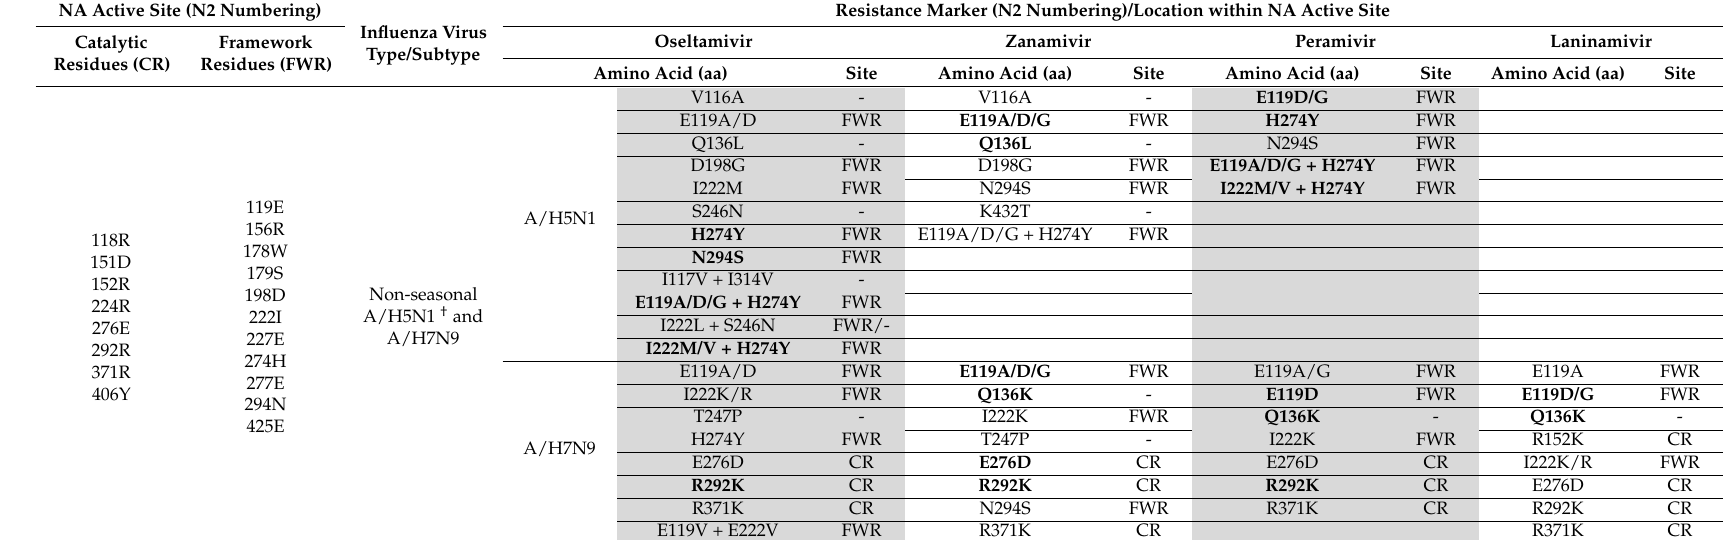
Table 4. Active site residues for all NA-subtypes and genetic resistance markers in viral NA proteins of highlighted non-seasonal human IAVs